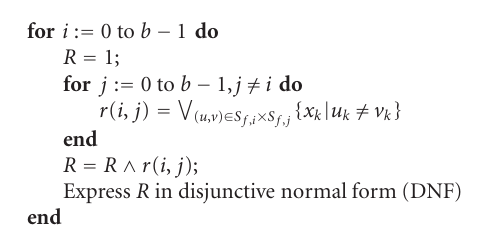
Algorithm 1: Algorithm to determine the collection of